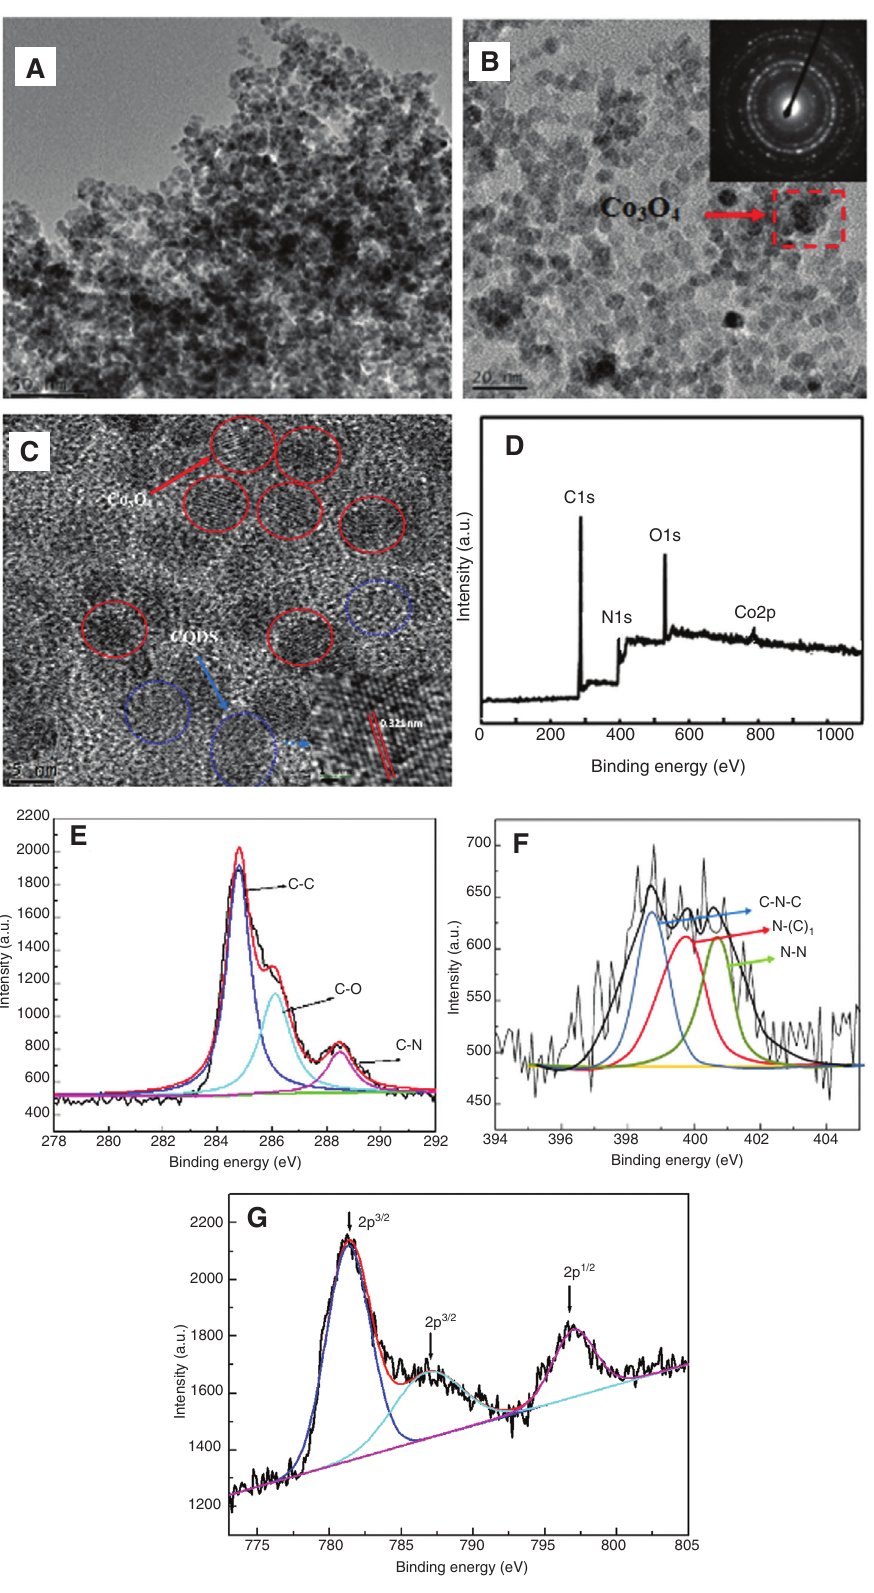
Figure 5: (A), (B) and (C) transmission electron microscopy (TEM) images of the as-synthesized Co/N/C. The inset in (B) is the diffraction rings of Co O marked in the red dash rectangle in (B), and the inset in (C) is the high-resolution TEM (HRTEM) image of crystalline C marked 3 4 in the blue circle in (C). (D) The full X-ray photoelectron spectroscopy (XPS) scan of Co/N/C. (E) High resolution of C1s, (F) N1s and (G) Co2p spectra of